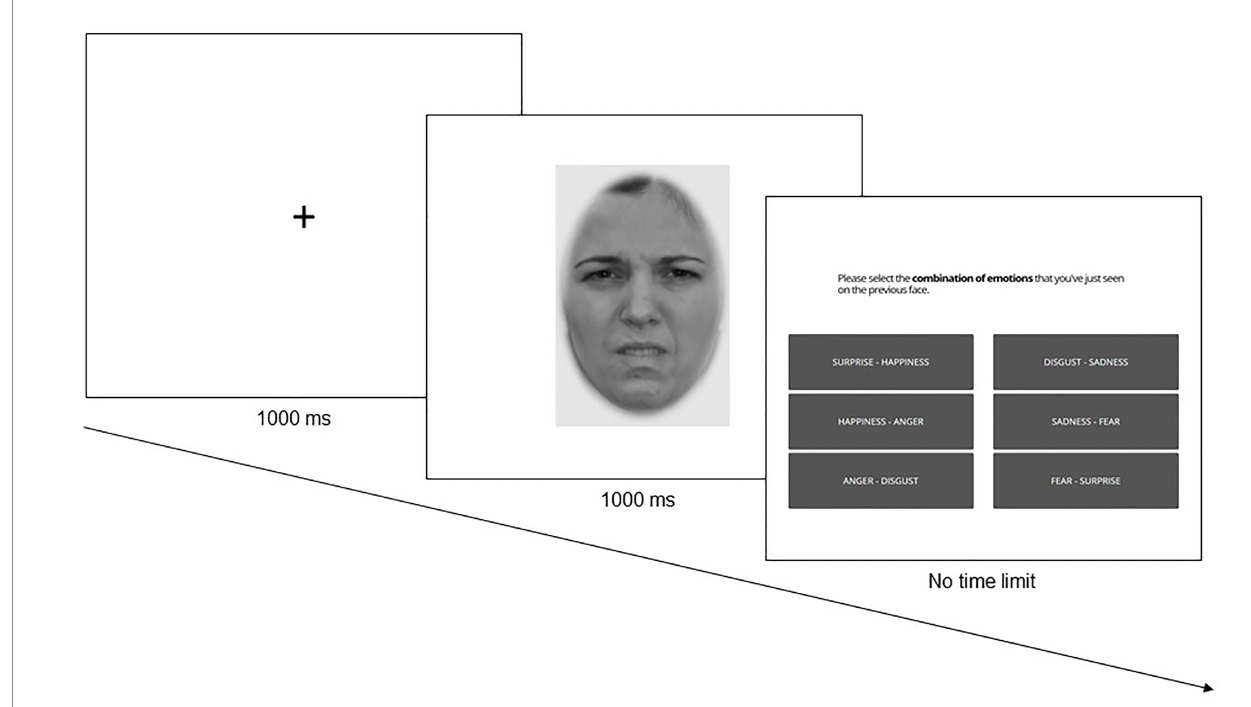
FIGURE 1 Example of a trial in the FEB task. Morphed face reproduced with permission from Wilhelm et al.